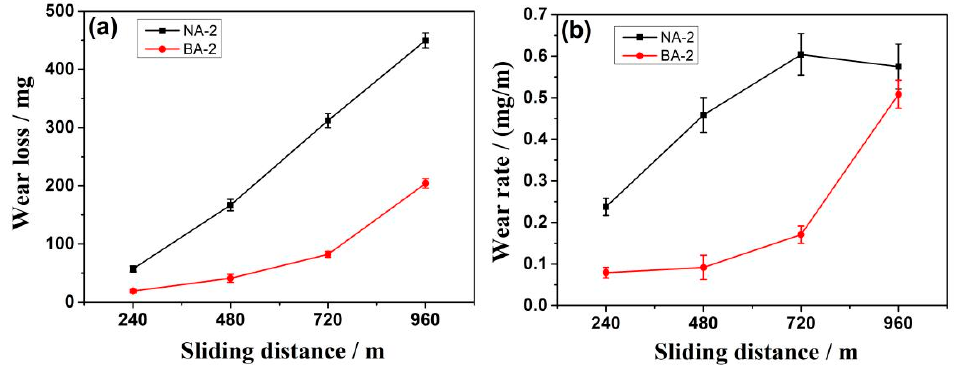
Figure 14. ( a ) wear loss and ( b ) wear rate of samples BA-2 and NA-2 in different wear durations.